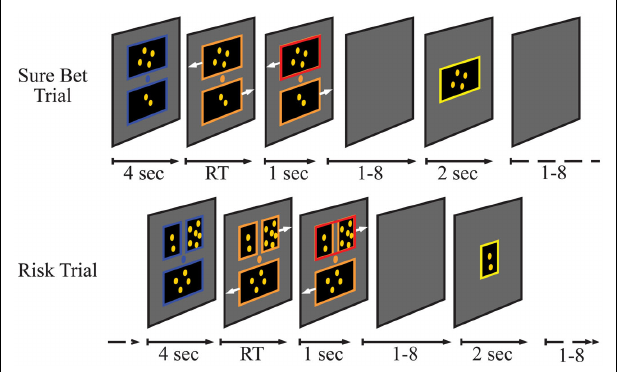
FIGURE 1 | Experimental design. Each trial consisted of a decision (blue frame), choice (salmon frame), confirmation (red frame), delay (no frame), and outcome (yellow frame) period.Trial types were psuedorandomized and presented over three 8-min runs.Variable timing for the delay and intertrial intervals were implemented to dissociate the temporal contingency between adjacent events. RT, response